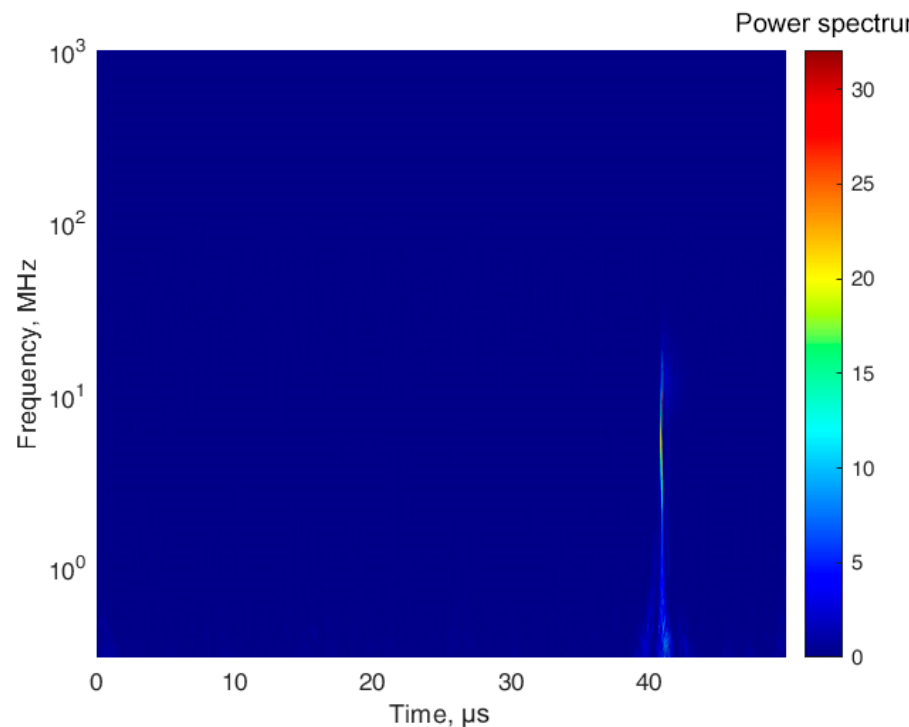
Figure 7. Wavelet spectrum of the signal induced in the nearby model element by the upward streamer corona flash.